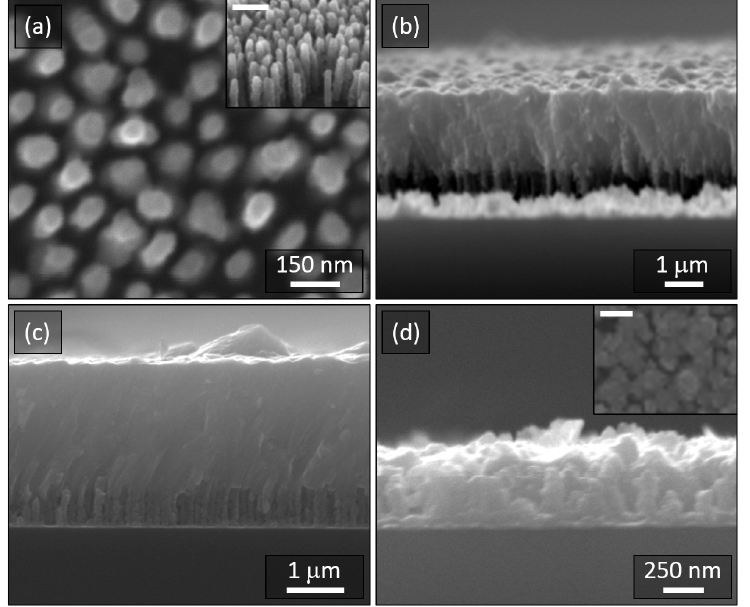
Figure 3. ( a ) Top-view scanning electron microscope (SEM) image of a dense array of Cu NWs supported on the Au-coated Si substrate. The inset shows corresponding tilted view representation of the vertically-aligned Cu NW array. SEM observations were performed after the complete removal of the supported AAO template. ( b – d ) Cross-section SEM micrographs of the CdTe thin film as- deposited on top of the Cu NW array by VTE ( b ), by RF-MS ( c ), and by ECD ( d ). The inset in ( d ) represents the corresponding top surface view of the CdTe-embedded Cu NW array. The scale bar of the insets is 250